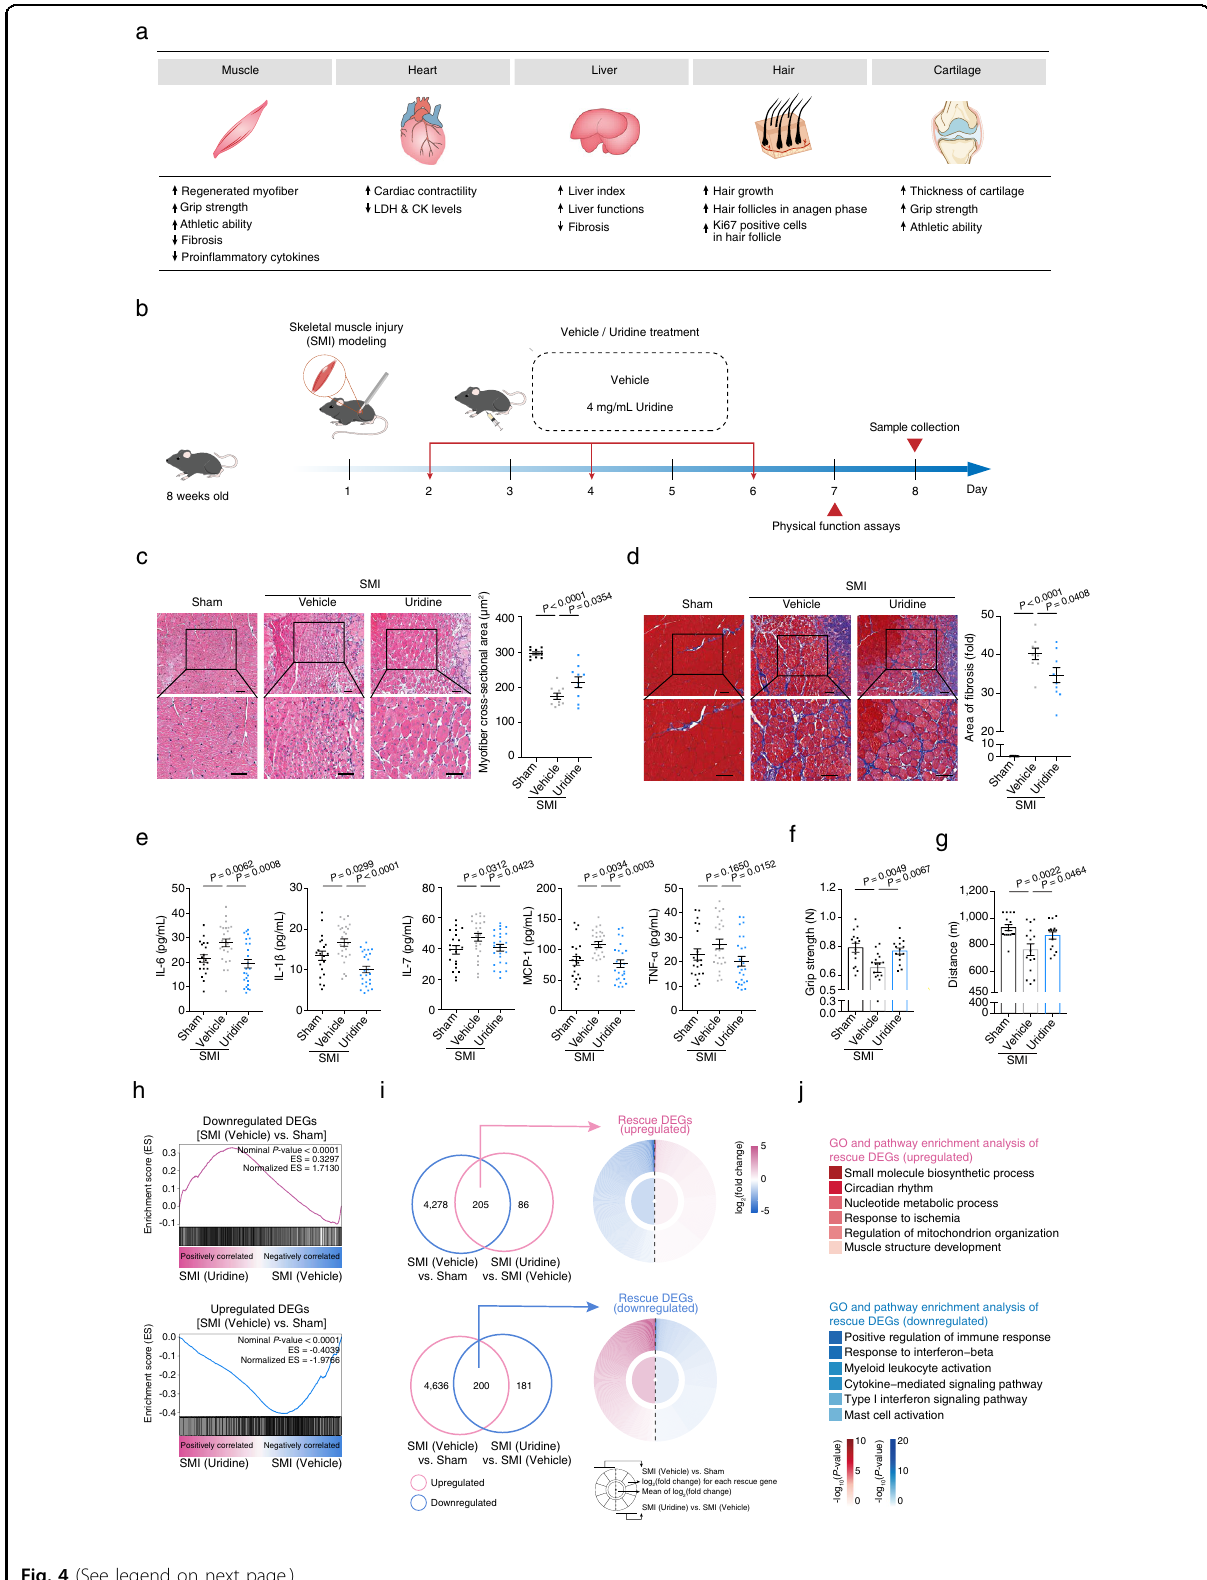
change)SMI (Vehicle) vs. Sham log 2 (fold change) for each rescue gene Mean of log 2 (fold SMI (Uridine) vs. SMI (Vehicle)